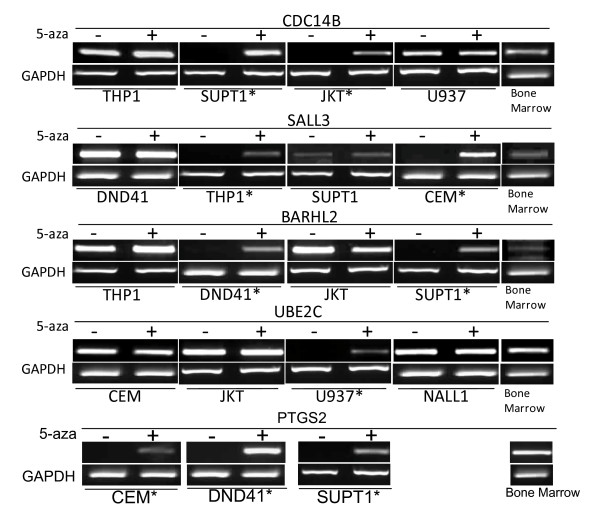
Re-expression of Methylated genes. Representative examples of leukemia cell line expression data. Expression from cell line RNA samples before demethylation treatment are labelled '-' and after demethylation treatment '+'. Methylated cell lines are labelled with a '*', expression of these genes in methylated cell lines before treatment could not be detected, expression in the same cell lines was detected after demethylation treatment. In unmethylated cell lines expression of these genes was detected before and after demethylation treatment to similar levels.